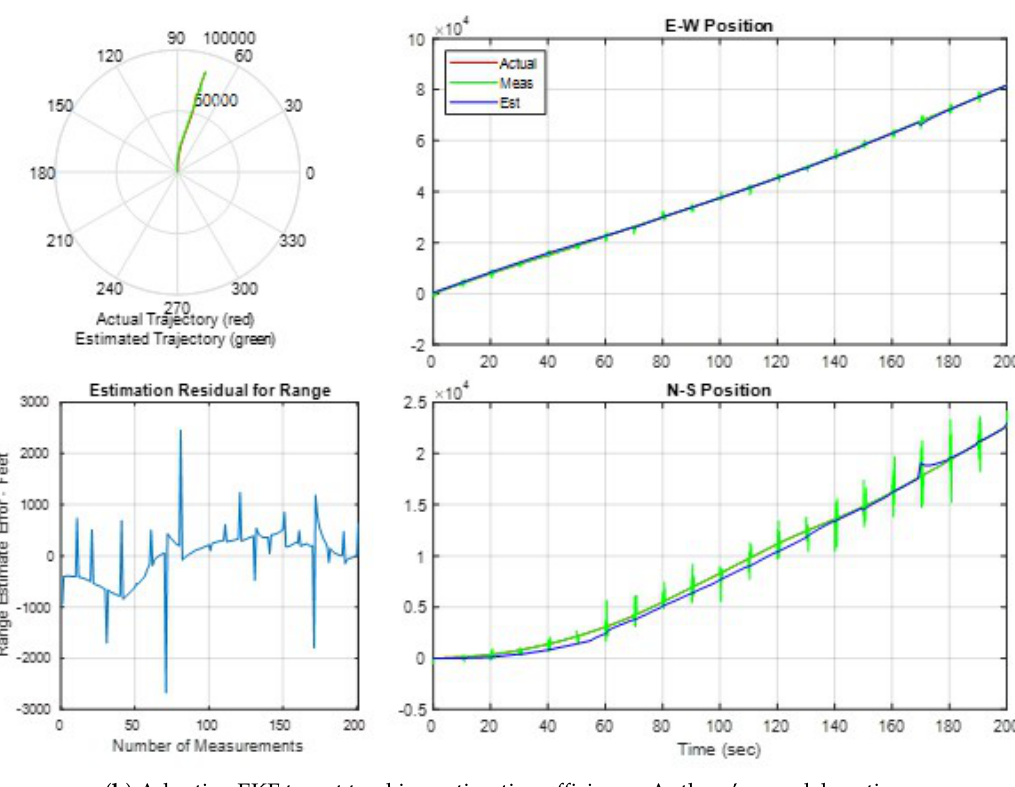
Figure 22. Performance comparison of considered filters for UAV tracking. Authors’ own